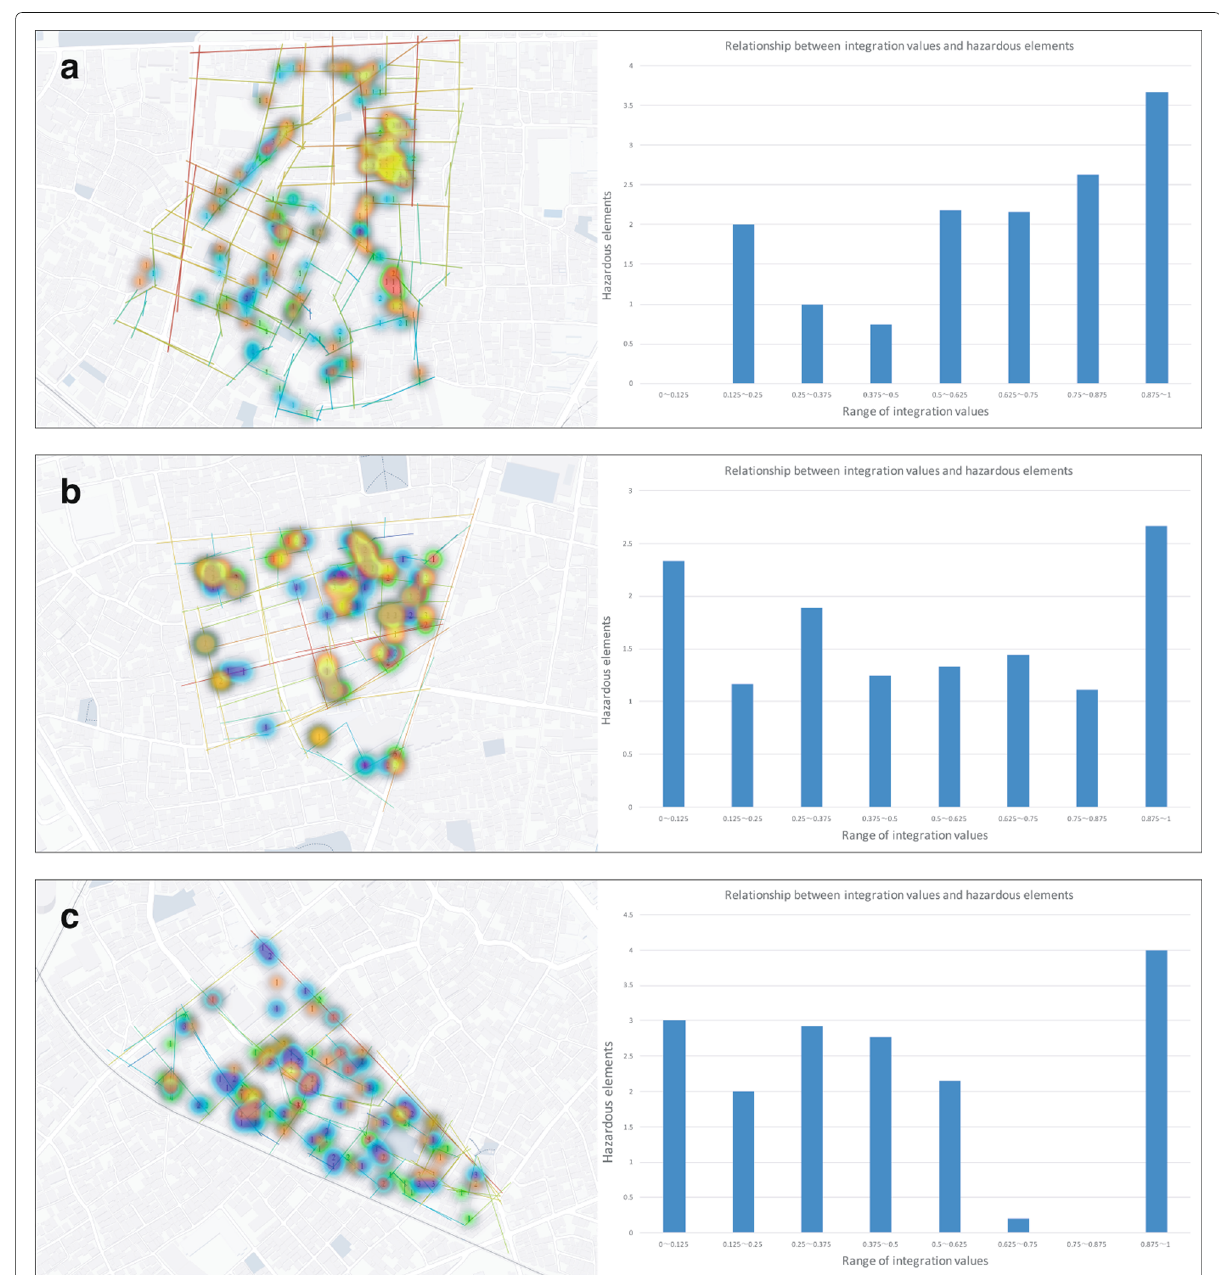
Fig. 6 Relationship between road network and hazardous elements. a) Machiya-4chome b) Senju-Yanagicho c) Kyoujima-2chome